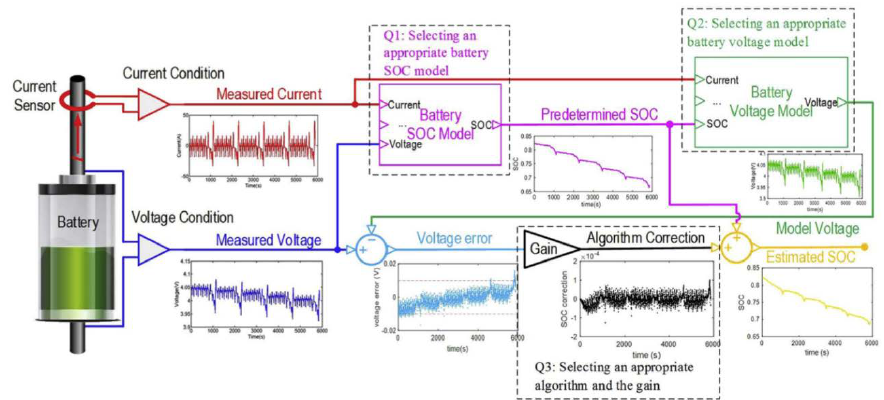
Figure 4. Flow chart of the adaptive filter algorithm of the modern control theory-based SOC estimation [83]. estimation [83].